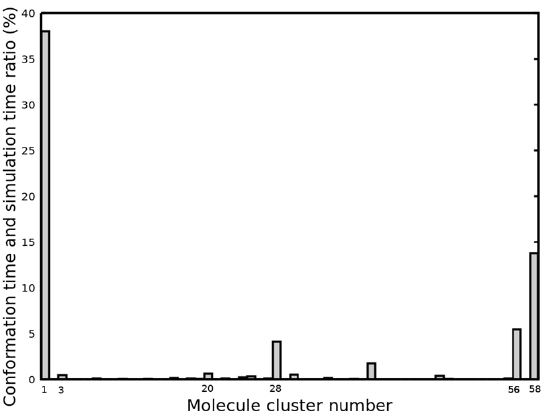
Figure 3. Cluster populations of the different KRSR peptide conformations, based on the lowest temperature simulation. temperature